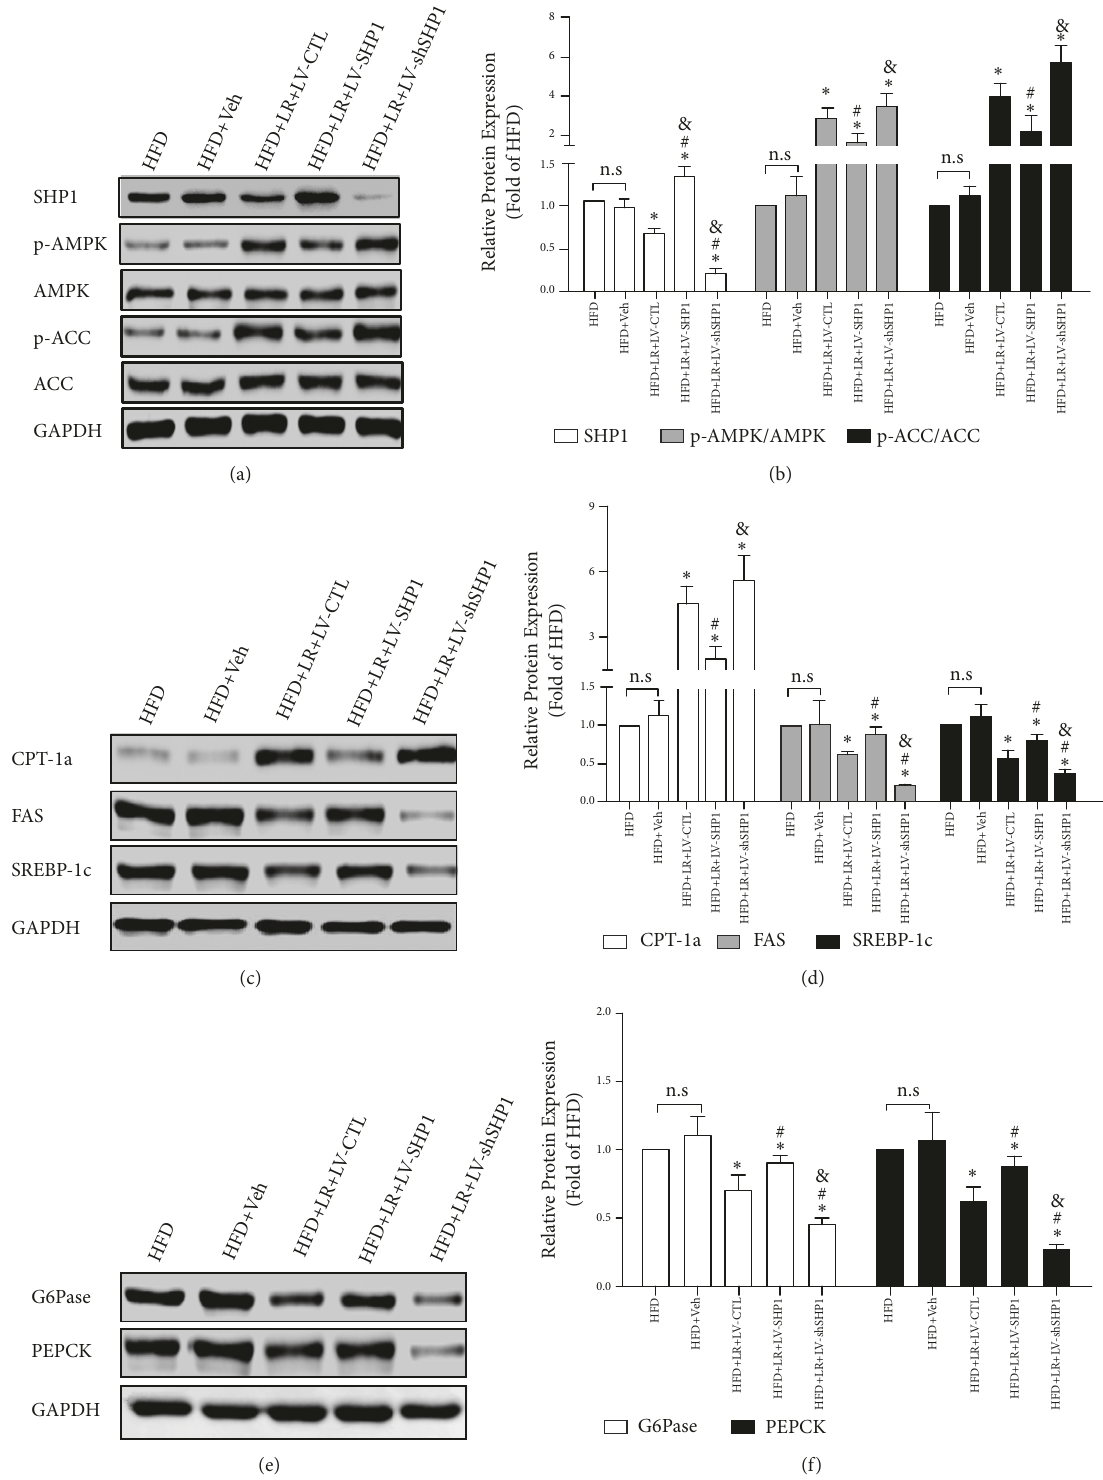
Figure 2: SHP1/AMPK pathway was involved in relieving effects of liraglutide on NAFLD in vivo . (a) The changes of levels of SHP1/AMPK pathway in all groups. SHP1, p-AMPK, AMPK, p-ACC, and ACC were detected by western blot and the representative images are shown. (b) The densitometry ratio of SHP1/GAPDH, p-AMPK/AMPK, and p-ACC/ACC are shown as mean ± SD of three independent experiments. (c) The changes of levels of lipid metabolic proteins expression in all groups. CPT-1a, FAS, and SREBP-1c were detected by western blot and the representative images are shown. (d) The densitometry ratio of CPT-1a/GAPDH, FAS/GAPDH, and SREBP-1c/GAPDH are shown as mean ± SD of three independent experiments. (e) The changes of levels of gluconeogenic proteins expression in all groups. G6Pase and PEPCK were detected by western blot and the representative images are shown. (f) The densitometry ratio of G6Pase/GAPDH and PEPCK/GAPDH is shown as mean ± SD of three independent experiments. The western blot results were normalized to the HFD group value. n.s. denotes no significance. ∗ denotes P < 0.05 versus the HFD+Veh group. # denotes P < 0.05 versus the HFD+LR+LV-CTL group. & denotes P < 0.05 versus the HFD+LR+LV-SHP1